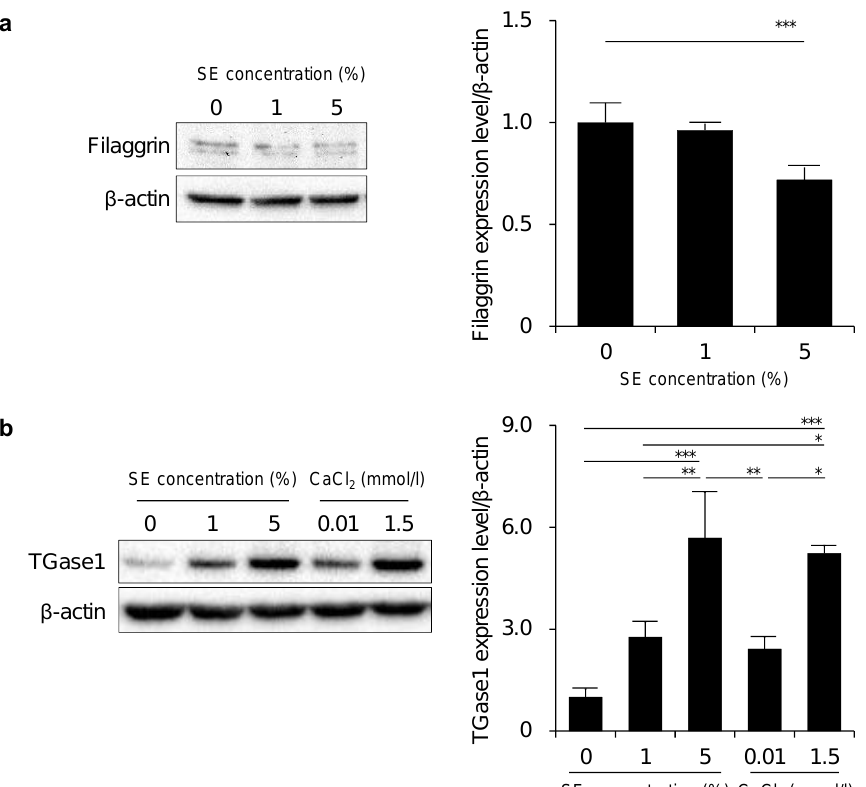
Figure 4. Effects of Shotokuseki extract on protein expression of differentiation markers in NHEKs. Cells were treated with Shotokuseki extract for 8 days. ( a ) Filaggrin and ( b ) TGase1 protein expression levels were assessed by quantitative Western blotting analysis. Each expression was normalized to the housekeeping protein β -actin. Data are expressed as mean ± S.D. of three independent experiments. * p < 0.05, ** p < 0.01, and *** p < 0.001. Statistical significance was evaluated using the Tukey’s post hoc multiple comparison